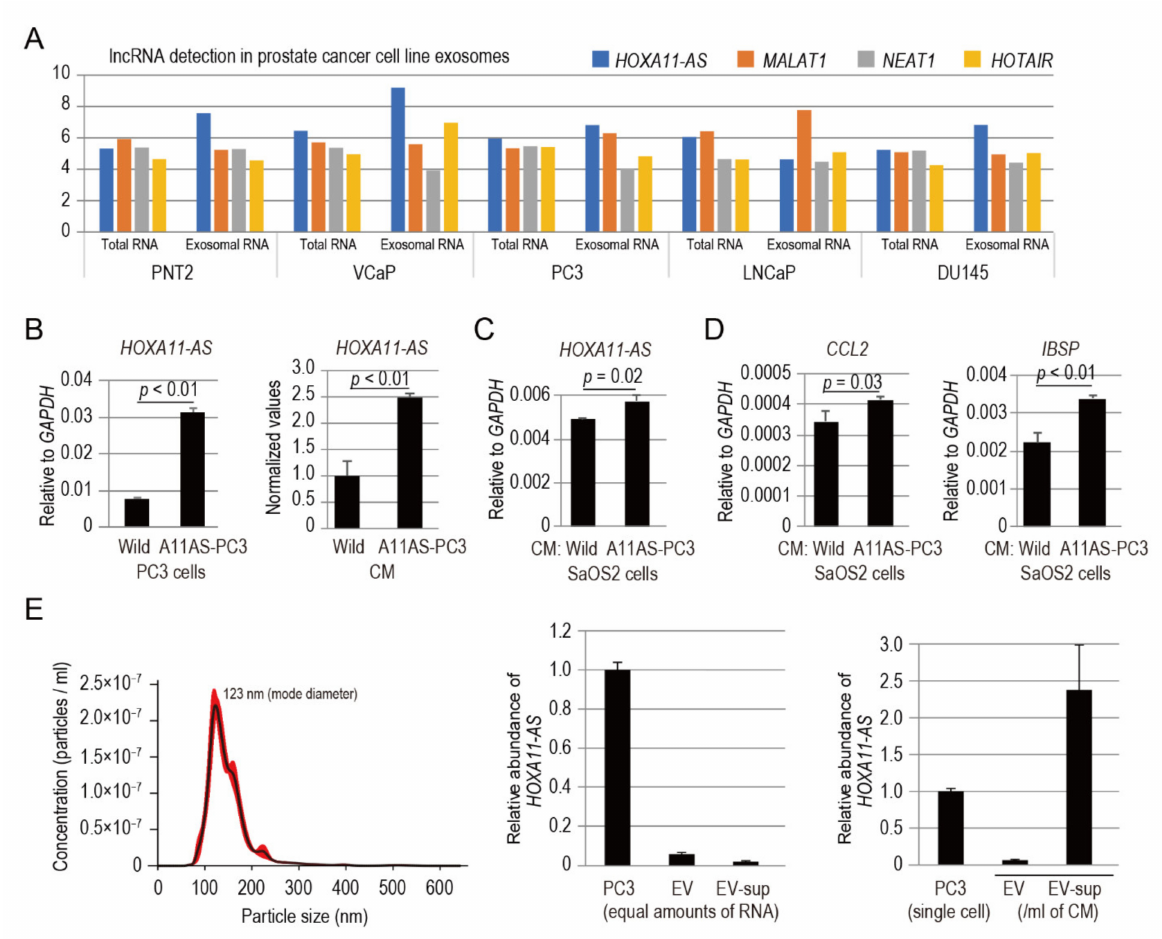
Figure 5. Prostate cancer PC3 cell-derived HOXA11-AS modulates IBSP and CCL2 expression in SaOS2 osteoblastic cells in a paracrine manner. ( A ) The expression levels of well-known, cancer metastasis-associated lncRNAs ( MALAT-1 , NEAT-1 , HOTAIR , and HOXA11-AS ) in exosomes of prostate cancer cell lines by comparison of exosomal RNA versus total RNA. A lncRNA array dataset from NCBI Gene Expression Omnibus (GSE81034) was used; values represent raw signal intensities. ( B ) HOXA11-AS expression of PC3 stable cells overexpressing HOXA11-AS (designated as A11AS-PC3) and wild type PC3 cells (Wild); HOXA11-AS detection in conditioned medium (CM) of A11AS-PC3 and Wild. ( C ) HOXA11-AS expression of SaOS2 cells treated for 48 h with CM of A11AS-PC3 and Wild. ( D ) CCL2 and IBSP expression of SaOS2 cells treated for 48 h with CM of A11AS-PC3 and Wild. qPCR analyses were performed in triplicate ( n = 3). Expression levels are presented relative to values of GAPDH , used as a reference gene, except for the right panel of B. The expression level of HOXA11-AS in CM of Wild was set to 1.0 in the right panel of B. Values represent mean ± standard deviation. Statistical significance was determined by unpaired t -tests. ( E ) Analysis of the size distribution of isolated EVs from wild type PC3-CM by the NanoSight nanoparticle tracking system (left panel). Comparison of relative abundances of HOXA11-AS in PC3 cell, and EV and EV-subtracted supernatant [EV-sup] fractions of PC3-CM by qPCR; equal amounts of RNA were applied (center panel). Relative abundances of HOXA11-AS in PC3 cell, and EV and EV-sup fractions are also shown as values per cell and values per mL of CM, respectively (right panel). The expression levels of PC3 were set to 1.0. Data are presented as mean ± standard deviation of triplicate data ( n =